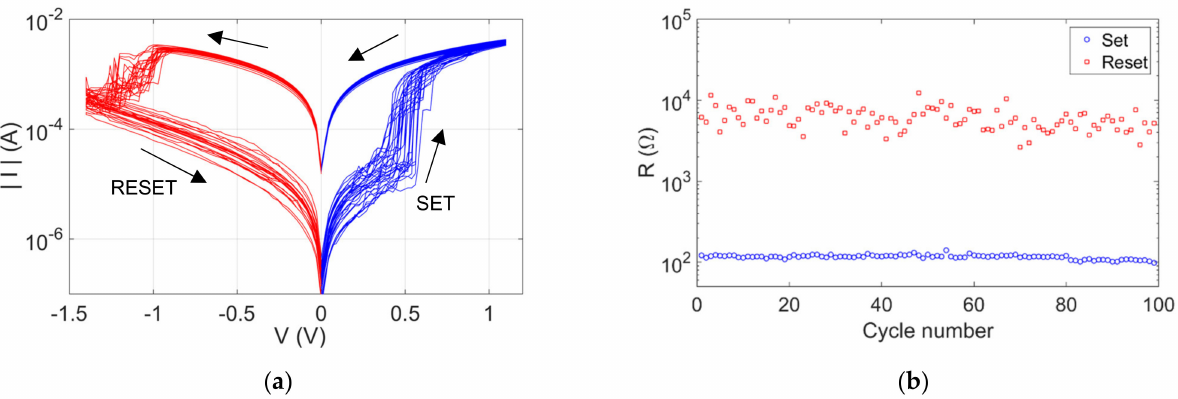
Figure 9. ( a ) DC resistive switching behavior during successive SET and RESET operations; ( b ) Resistances during pulsed SET and RESET operations.